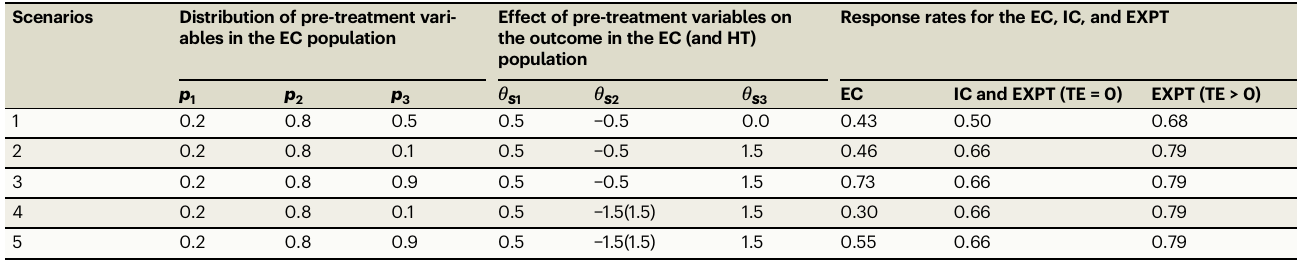
Table 1 | Model-based simulation scenarios